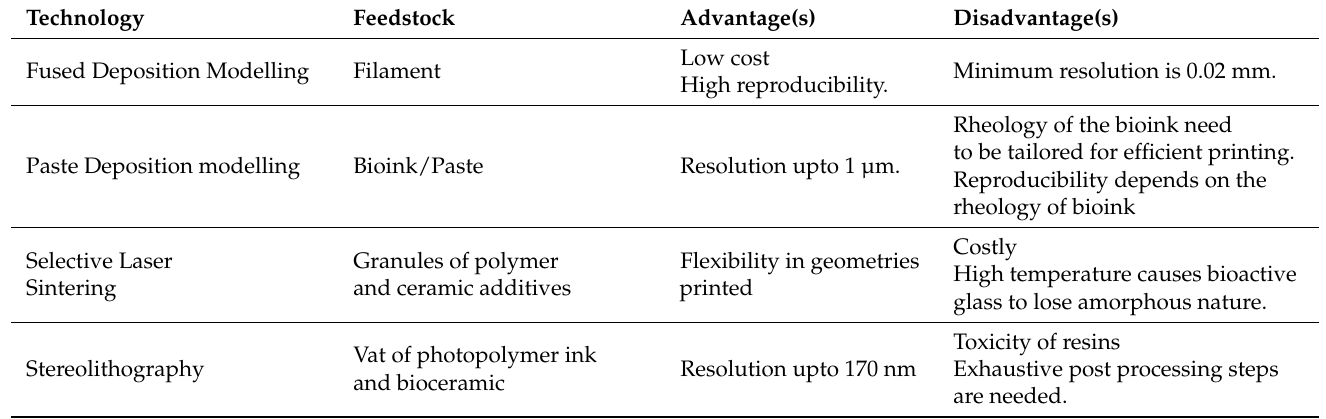
Table 1. Advantages and disadvantages of different 3D printing technologies used for the fabrication of polymer-bioactive glass composite